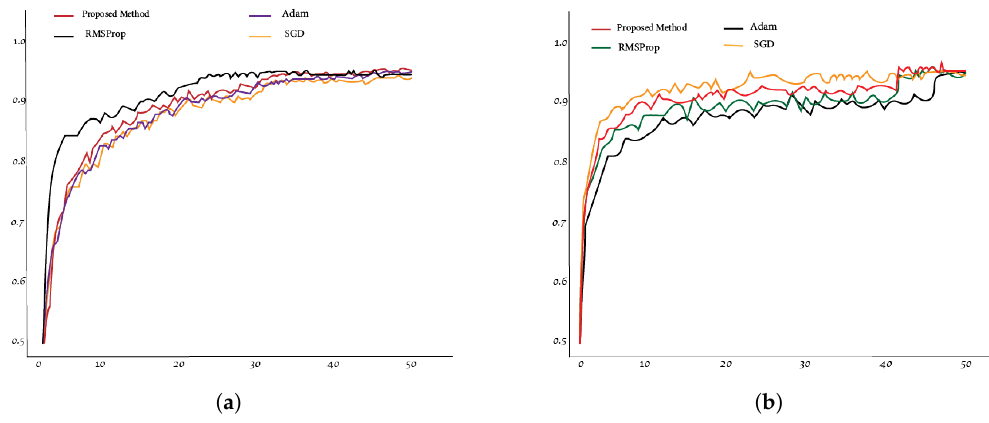
Figure 6. Training and testing of DenseNet121 with various optimizers on the CIFAR-100 dataset. ( a ) Training accuracy. ( b ) Testing